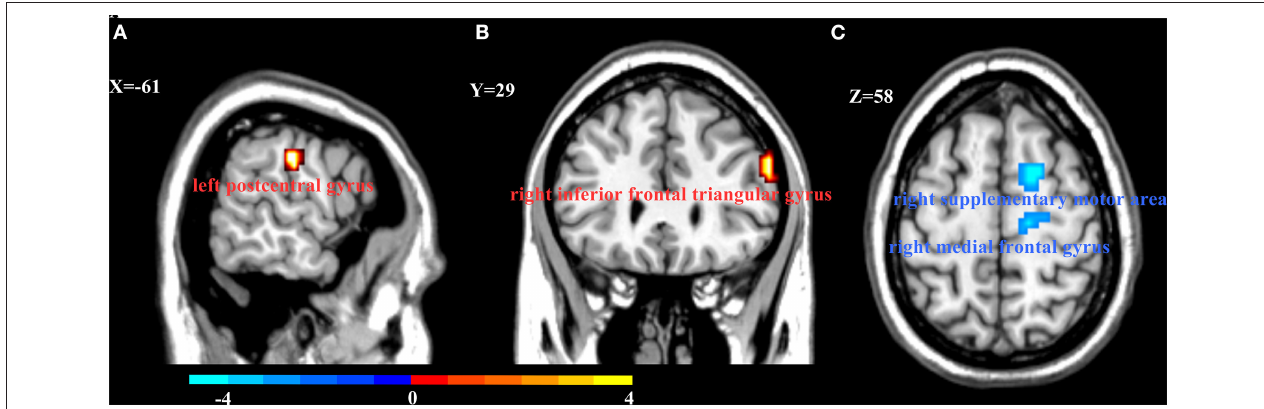
FIGURE 1 | Interaction between onset age and depression on Regional homogeneity (ReHo). Compared with young HCs and LOD patients, EOD patients had increased ReHo in the left postcentral gyrus (A) and right inferior frontal triangular gyrus (B) . However, EOD patients had significantly decreased ReHo in the right superior frontal gyrus/supplementary motor area and the right medial frontal gyrus (C) than young HCs. Color bar represent the t -value.